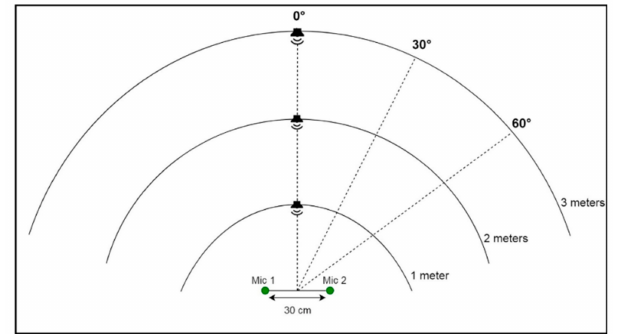
Figure 1. Training data recording